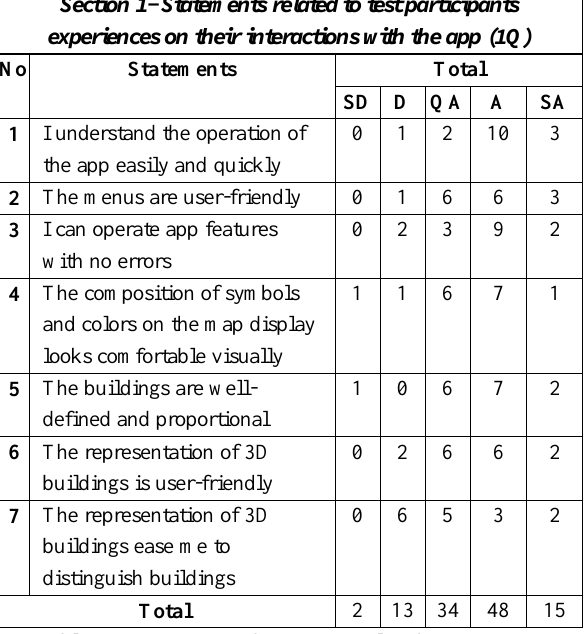
Table 2. Statements and responses related to Section 1 Section 1 is presented in Table 3.